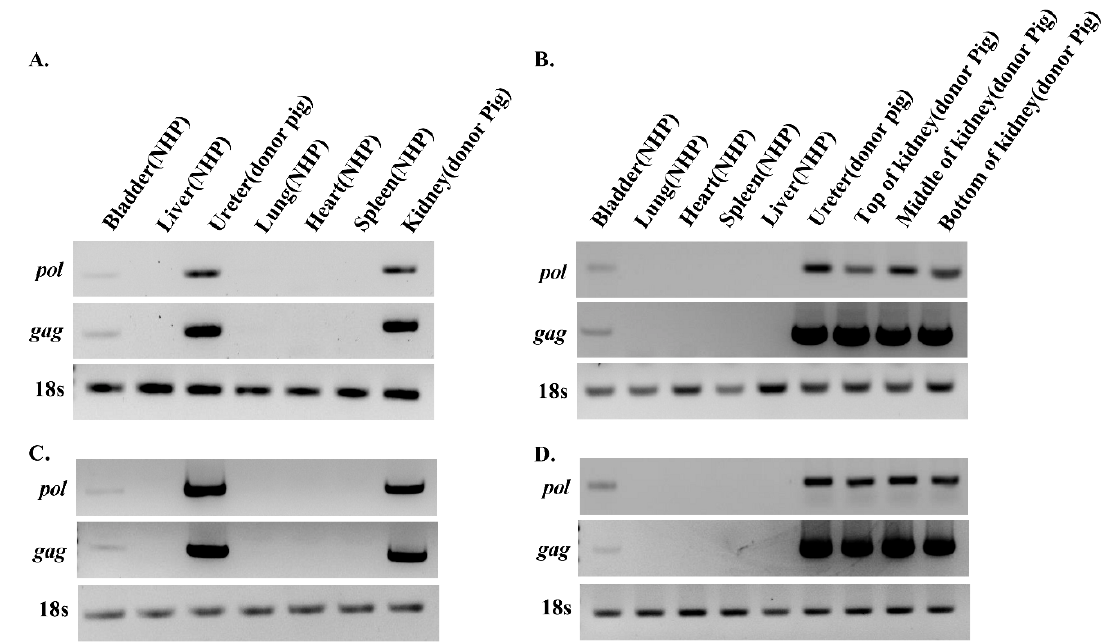
Figure 2. Analysis of PERV in different tissues of the kidney transplanted recipients by PCR. The PERV gag and pol were detected by PCR and RT-PCR from different tissues of the kidney transplanted recipients. ( A ) gDNA and ( C ) cDNA of the kidney transplanted recipients NHP 20-06. ( B ) gDNA and ( D ) cDNA of the kidney transplanted recipients NHP 23-30.